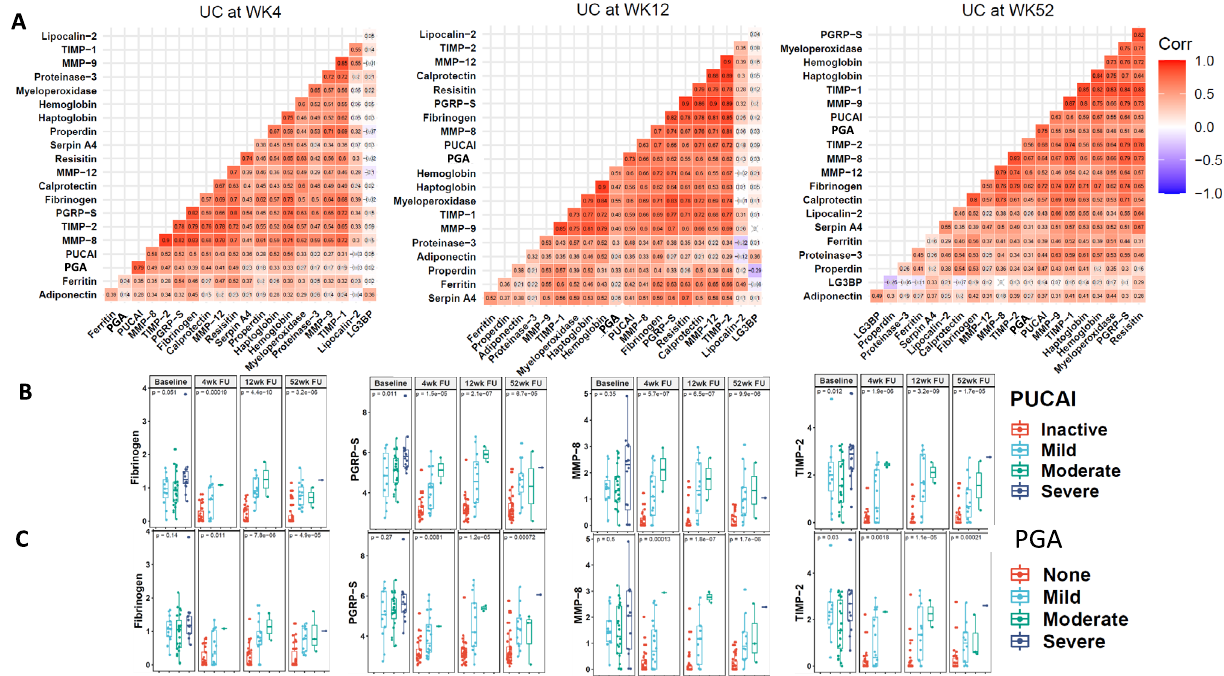
Fig. 4 Longitudinal analysis of stool protein biomarkers in PROTECT Study participants. A A pairwise Pearson ’ s correlation analysis was performed for 19 stool proteins along with PUCAI and PGA disease severity indices across three follow-up time points, WK4, WK12, and WK52, in 50 UC patients from the PROTECT cohort. At each time point, the markers that are strongly correlated with PUCAI and PGA were grouped based on their correlation coef fi cient. Pearson correlations that are not signi fi cant at p < 0.05 are crossed out. As a result, 4 markers “ Fibrinogen ” , “ MMP-8 ” , “ PGRP-S ” , and “ TIMP-2 ” were identi fi ed since they show a strong positive correlation with PUCAI and PGA disease severity index scores at most of the follow-up time-points. B Boxplot representation shows the association of 4 selected stool proteins with the PUCAI disease severity groups (Inactive, Mild, Moderate, and Severe) across multiple time-points, in 50 UC patients from the PROTECT cohort. Shown p-values were calculated using the anova test in R. C Boxplot representation showing the associations of each selected stool protein with PGA disease severity groups, (None, Mild, Moderate, and Severe) across multiple time-points. Shown p -values were calculated using the anova test in R. In each boxplot the middle line represents the mean value and outer two- line bars represent the data range. Symbols shown outside the bar range indicate